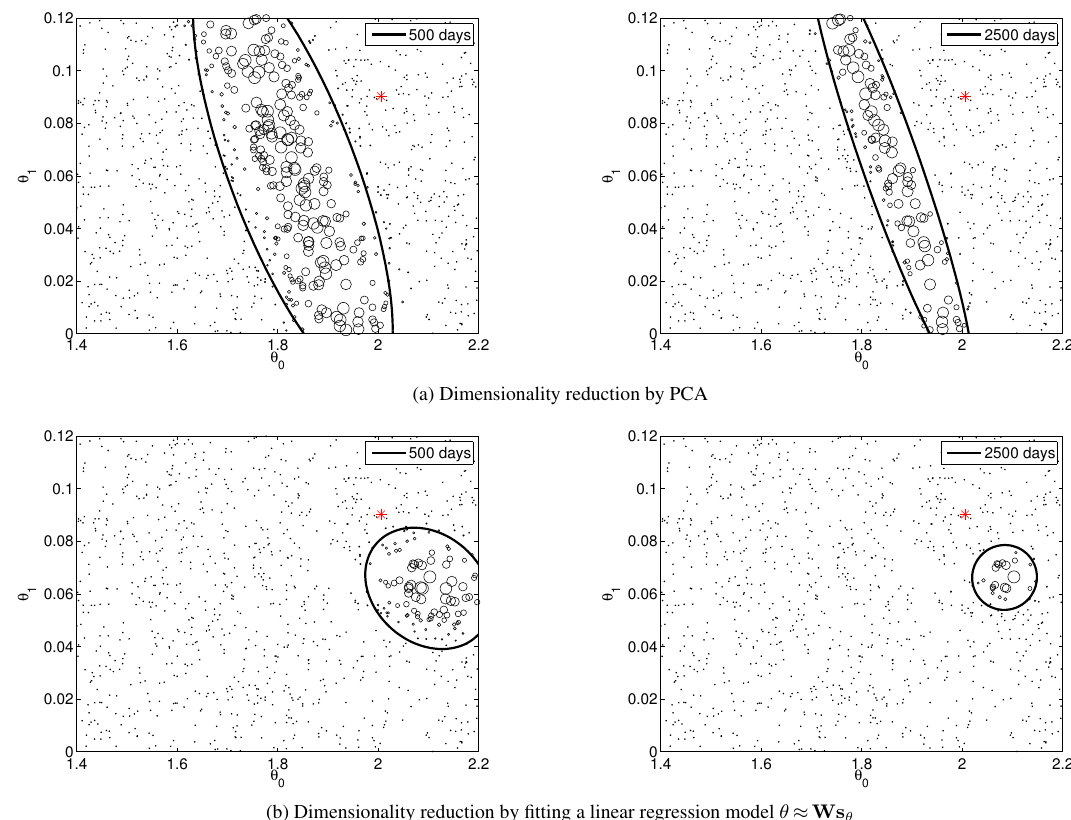
Fig. 3. The scatter plots of the parameter value candidates and their likelihood (represented by the size of the markers) obtained with cost function (11). The simulation length is 500 days (left) and 2500 days (right). The marker size reflects the value of the weights for importance sampling. The black ellipses represent the first two moments estimated with importance sampling. The red start represents the parameter values estimated by fitting the forcing model to the simulated fast variables (see Section 5 for details).